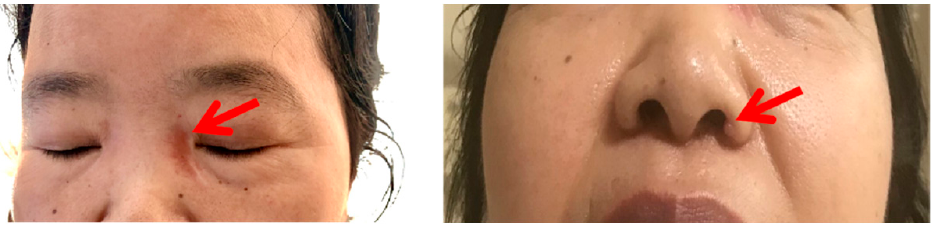
Figure 1. The erythema at the left inside canthus skin and the small nodule on the left nasal alar.